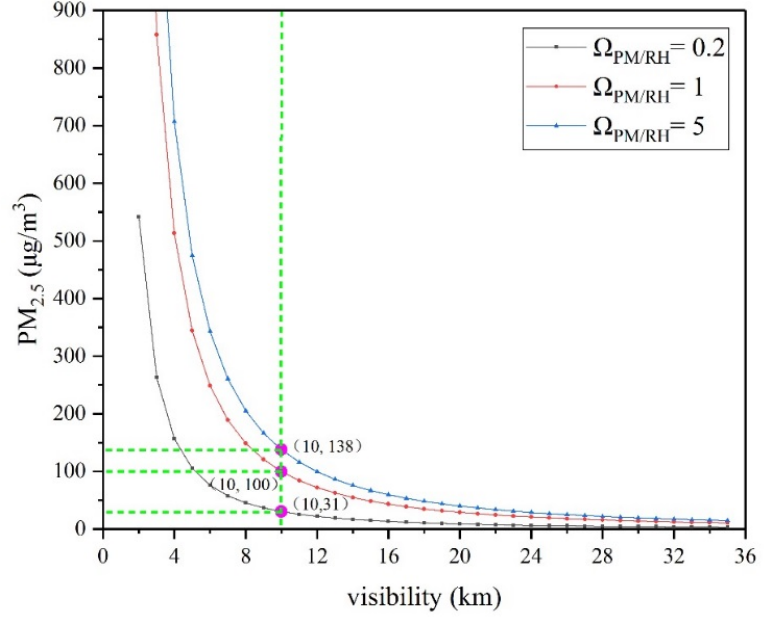
Figure 4. The PM 2.5 thresholds for different visibility-sensitive regimes ( Ω PM/RH = 0.2, 1, and 5, respectively) under different visibility levels in Tianjin, 2015.